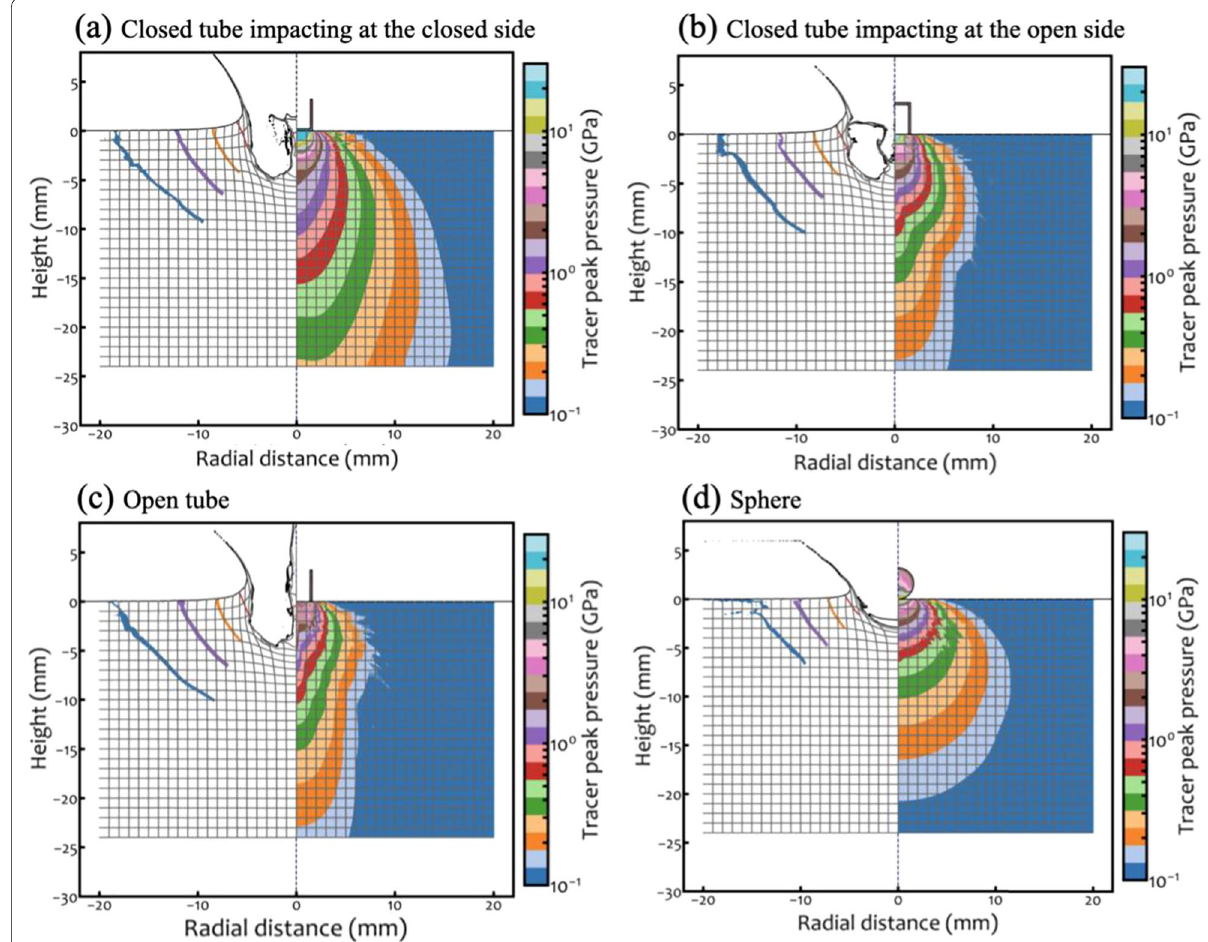
Fig. 5 Results of the numerical simulations for a a closed copper tube impacting at the closed side, b a closed copper tube impacting at the open side, c an open copper tube, and d a solid aluminum sphere. The projectile collides perpendicularly at the origin of the coordinate from the top. The right half shows the contour of the maximum (peak) pressures experienced. The left half shows the contour of the upward particle velocity; the blue, purple, orange, and red lines indicate 3, 10, 30, and 100 m/s,